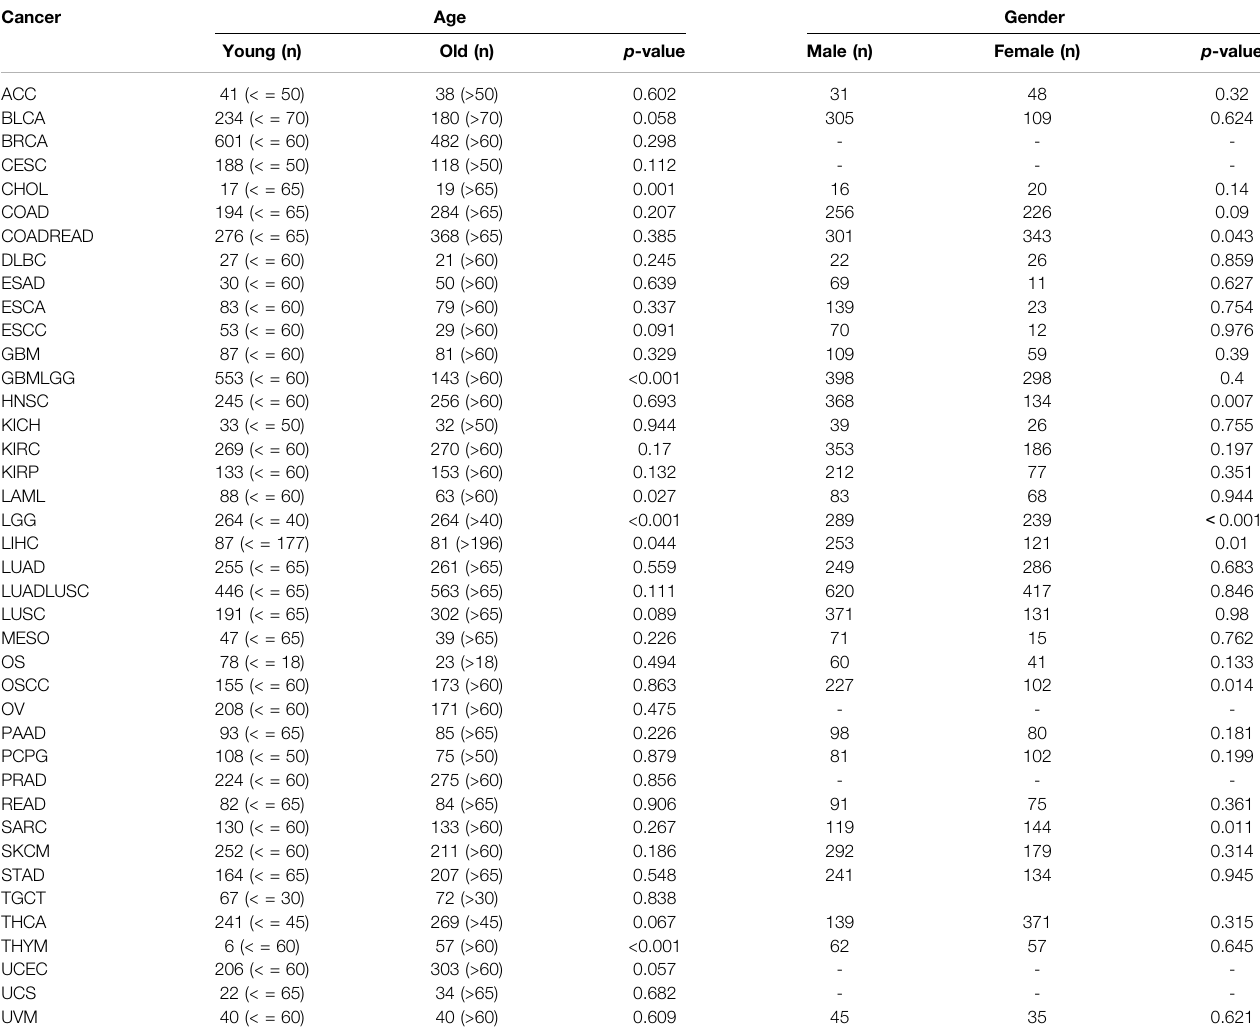
TABLE 2 | BCL7B expression p associated with age and gender of cancer patients in pan-cancer. * Categorical-dependent variables, greater or less than the median expression level. Cancer